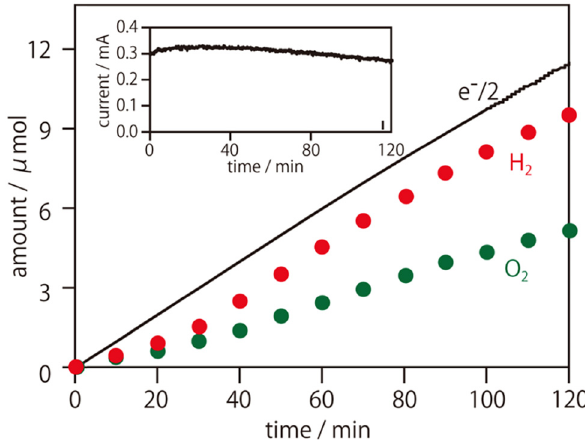
of Zn 2 + in CZTS being substituted with Cd 2 + ) showed the